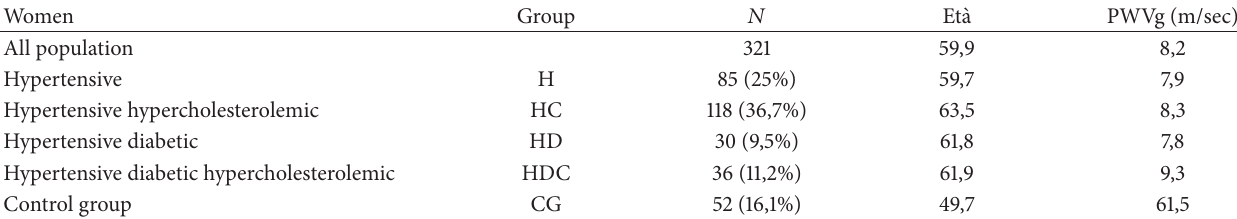
Table 1: PWVg in the different postmenopausal women groups and control